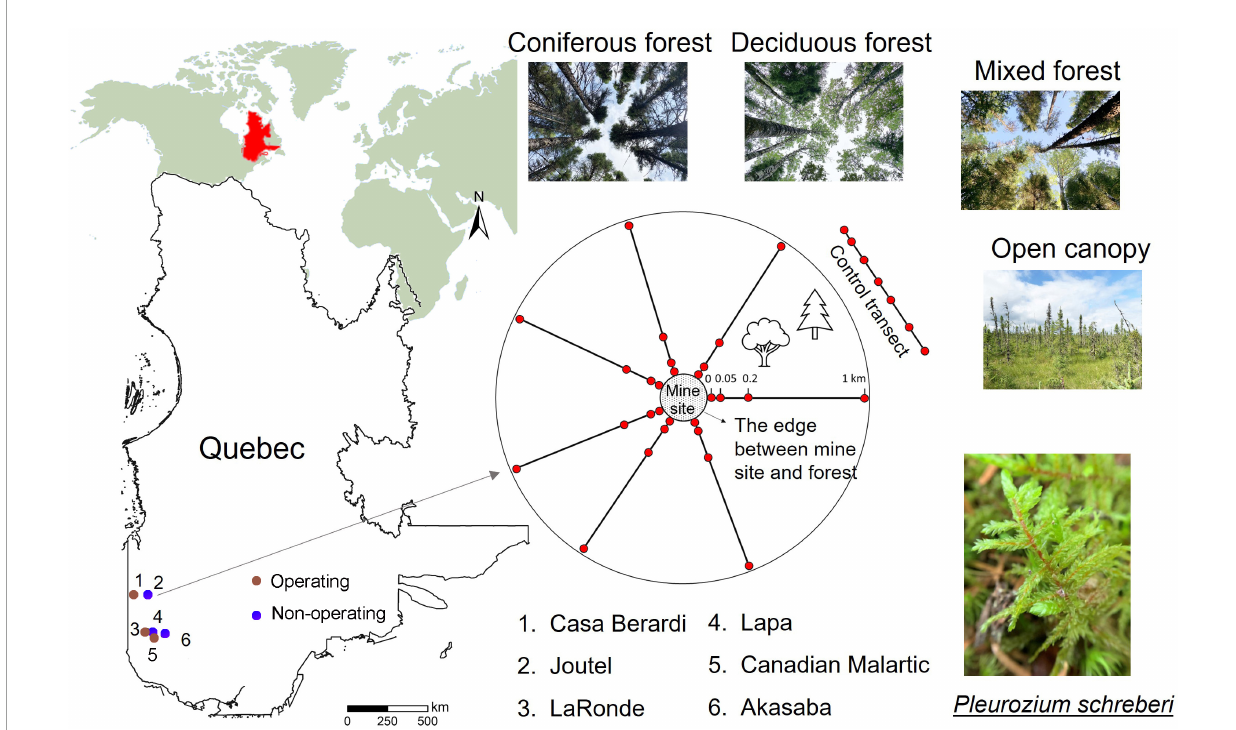
FIGURE1 Study sites. (Left) Map of Quebec showing the location of the six gold mine sites. (Right) Sampling design. The four sampling plots at 0, 0.05, 0.2, and 1 km from the border of mine sites along transects at each study site are indicated by red circles. Six control transects were established near mine sites (see Supplementary Figure 1